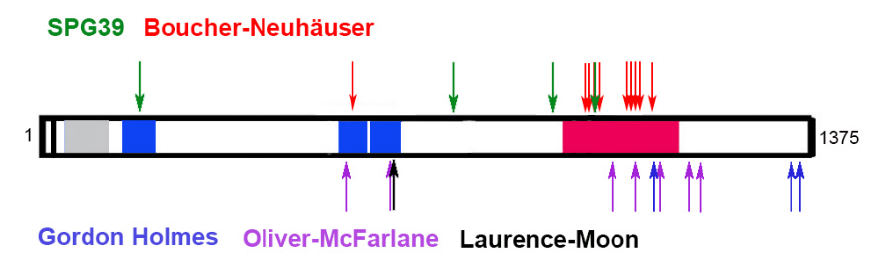
Figure 5. Disease-causing mutations in PNPLA6/NTE. Shown are only point mutations associated with the different syndromes. The cyclic nucleotide binding sites (aa195-322, aa511-633 and aa629-749) are shown in blue. The phospholipase domain (aa981-1147) is shown in red. Table 1. PNPLA6-related disorders. Characteristic clinical features are indicated by +. Clinical features not detected in all patients are indicated by +/ −